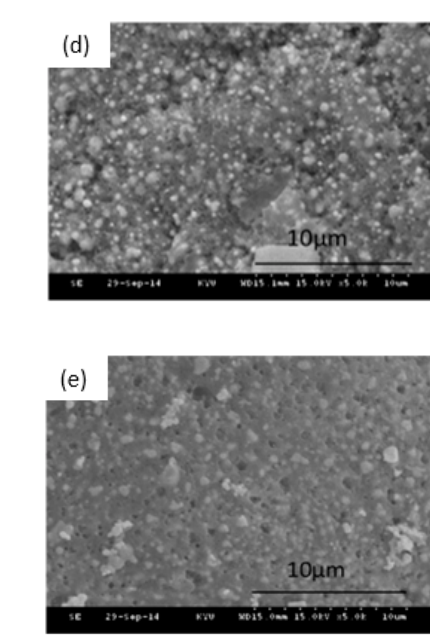
Figure 2. XRD patterns of Ag1/80S after immersion in PBS for different times.